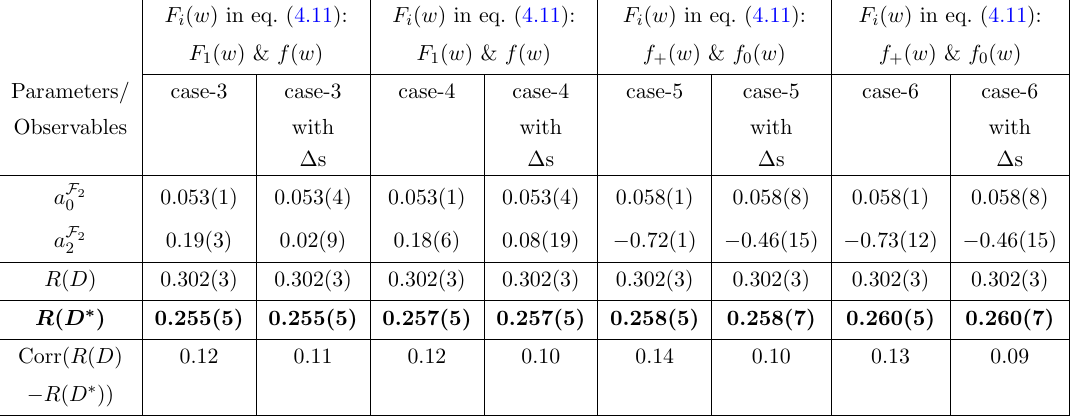
Table 17 . The predictions for R ( D ( (cid:3) ) ) using the (cid:12)t results of the HQET parameters given in table 15. The rest of the assumptions are same as that given in the caption of table